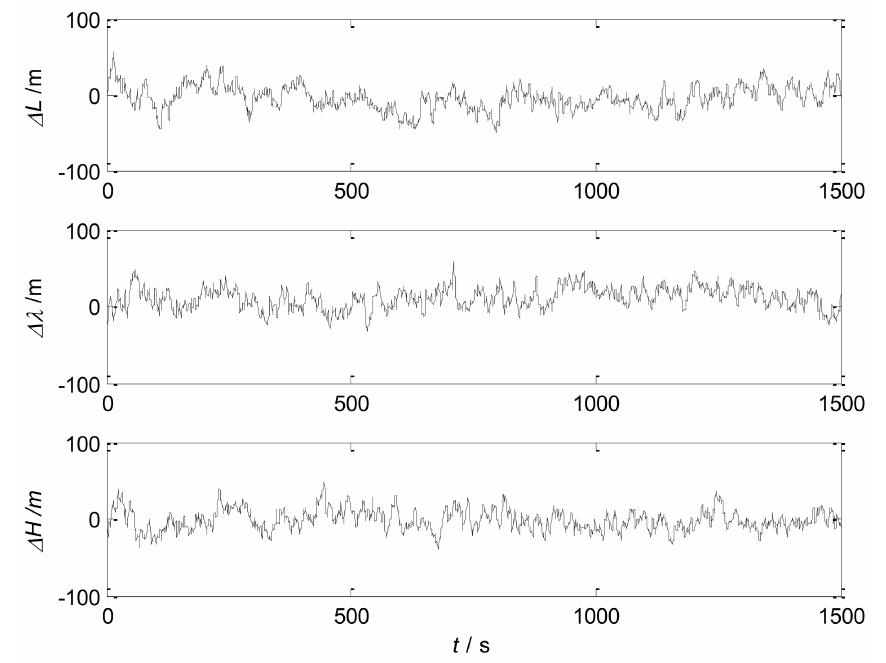
Figure 7. Position error of the autonomous integrated navigation